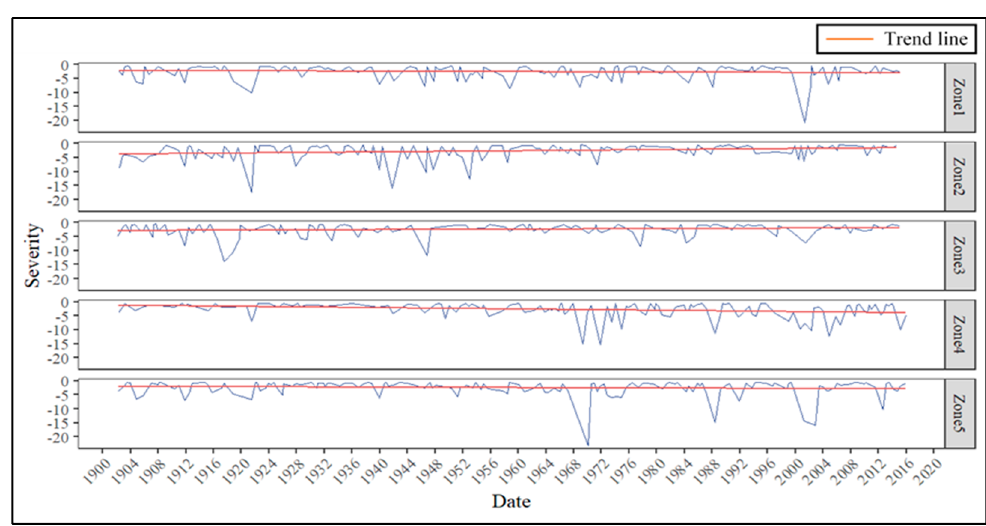
Appl. Sci. 2019 , 9 , x FOR PEER REVIEW Figure 15. Drought durations for each zone. Figure 15. Drought durations for each zone.